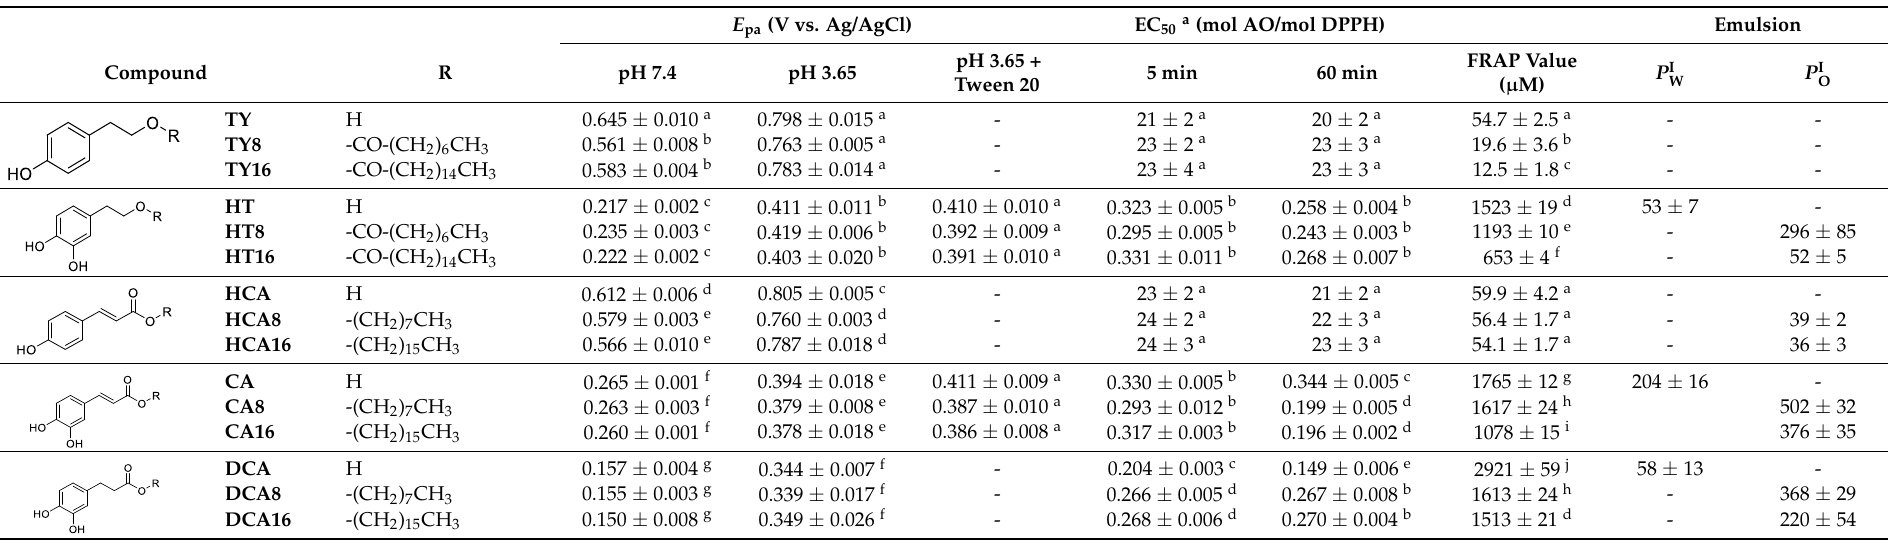
Table 1. DPPH% Radical-scavenging capacity, EC 50 a , oxidation peak potentials, E pa , FRAP values and values for 𝑃 wI and 𝑃 O I of compounds in O/W emulsions. E pa (V vs. Ag/AgCl) EC 50 a (mol AO/mol DPPH) Emulsion